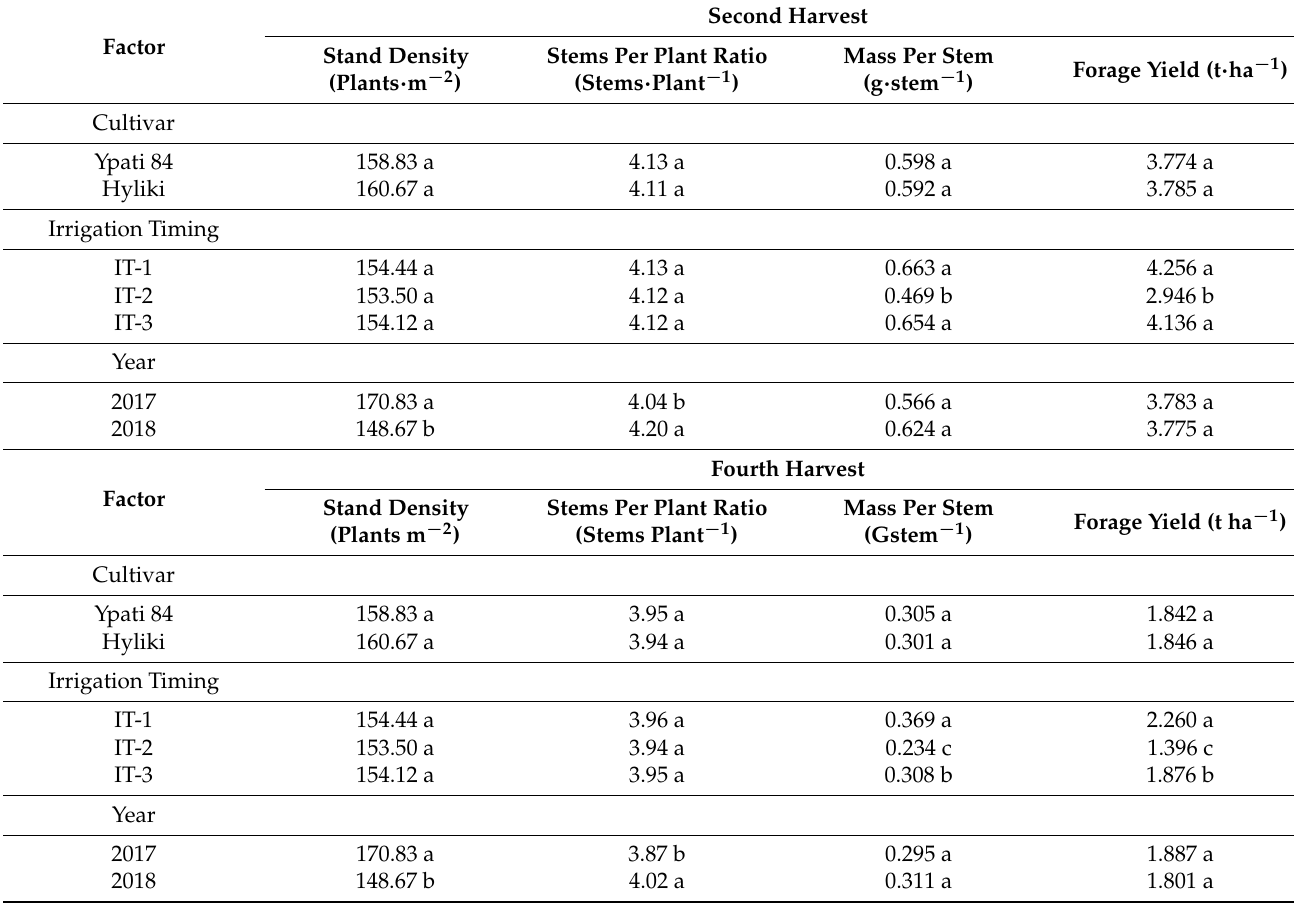
Table 8. The stand density (plants · m − 2 ), stems per plant ratio (stems · plant − 1 ), yield per shoot (g · shoot − 1 ), and forage yield (t · ha − 1 ) values recorded, in the second and the fourth harvest, across the two experimental years.